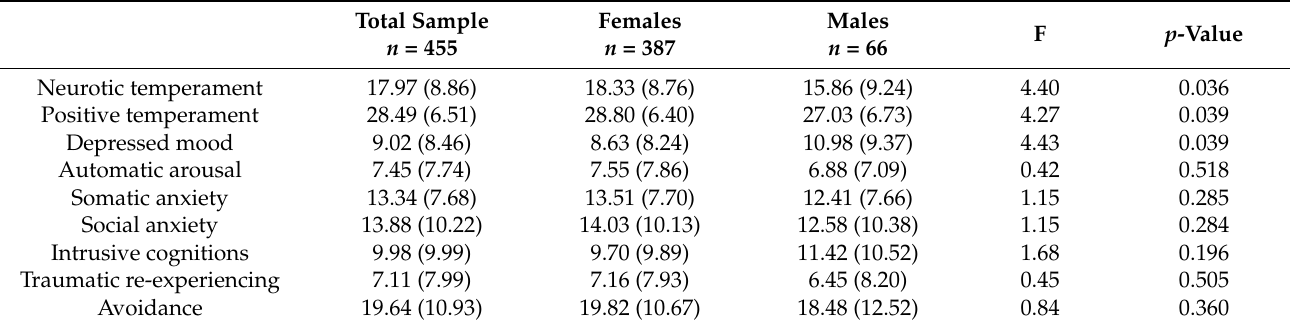
Table 4. Sex differences in MEDI scales total